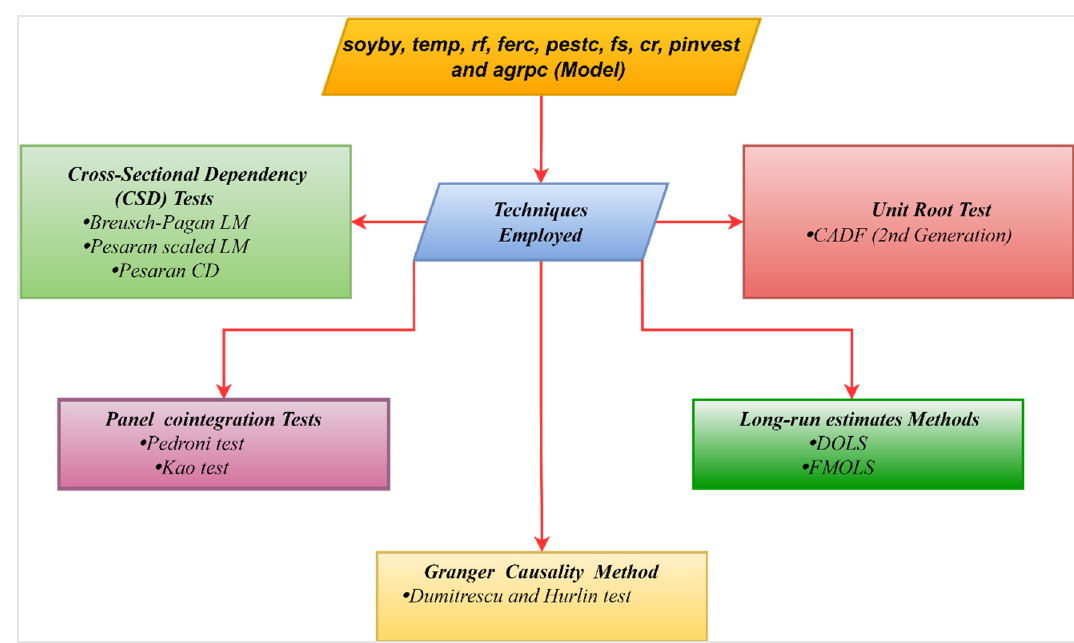
Figure 3. Steps of econometric strategy for the presenet study.